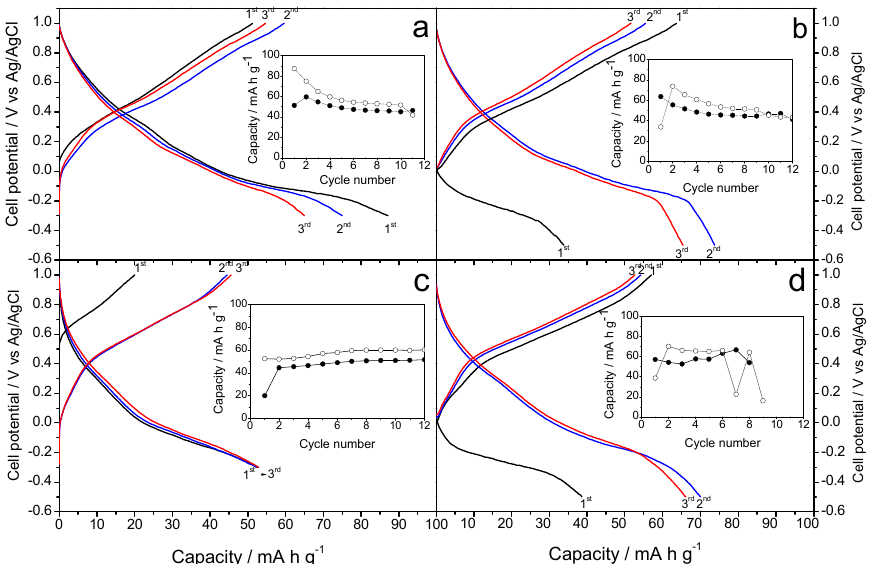
Figure 4. Galvanostatic curves in aqueous Na 2 SO 4 -based electrolyte and referring the voltages to the Ag / AgCl electrode recorded at C / 8: ( a , b ) Na-B / SS starting with ( a ) charge and ( b ) starting with discharge ( c , d ) Na-B / HT starting with ( c ) charge and ( d ) starting with discharge. Insets: capacity vs. cycle number (open circles: discharge, filled circles: charge).